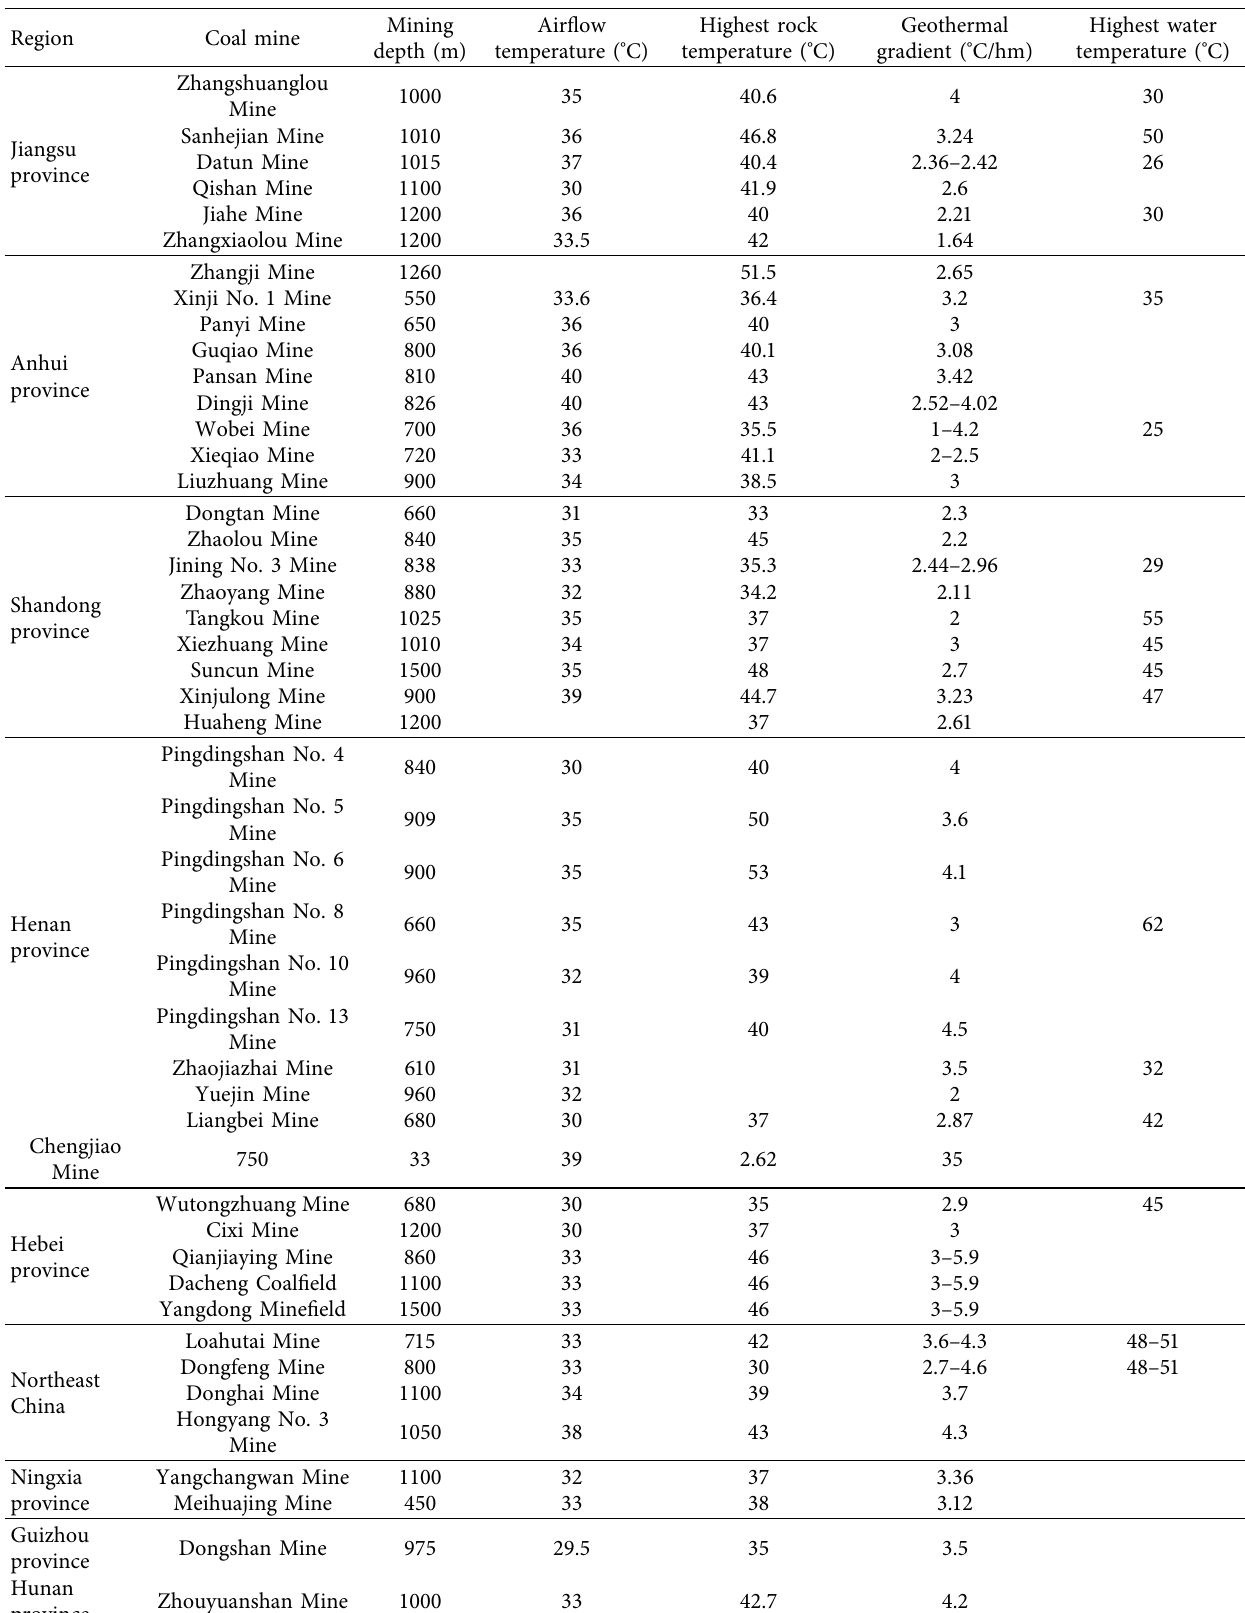
Table 1: Incomplete statistics of thermal hazards of mines in China